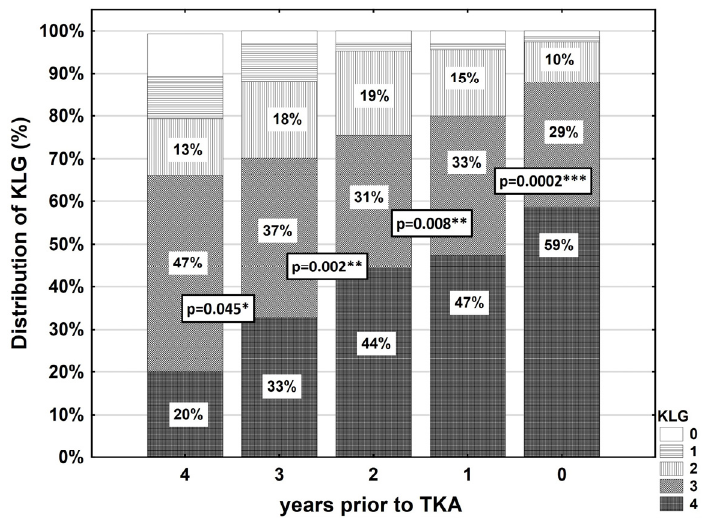
Figure 2. Longitudinal change in the distribution of Kellgren and Lawrence grades (KLG) ≥ 2 [19,20] of the total sample consisting of 165 individuals in the years 4–0 prior to total knee arthroplasty (TKA) surgery. Significance levels are indicated by *: p ≤ 0.05, **: p ≤ 0.01, ***: p ≤ 0.001, and represent the comparison to the previous year: 3 vs. 4, 2 vs. 3, 1 vs. 2 and 0 vs. 1. Statistical testing was performed with McNemar’s test.